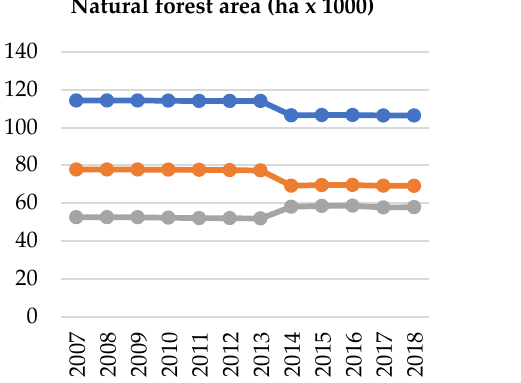
Figure 5. Area of natural forest and plantation forest in the study districts. Source: Reproduced with permission from Dak Figure 6. Area of natural forest and plantation forest in the study districts. Lak Forest Protection Department